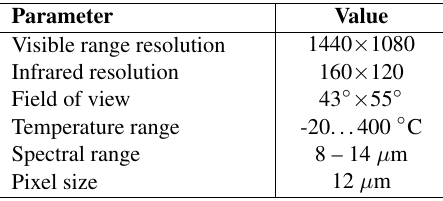
Figure 2. Generator network architecture.